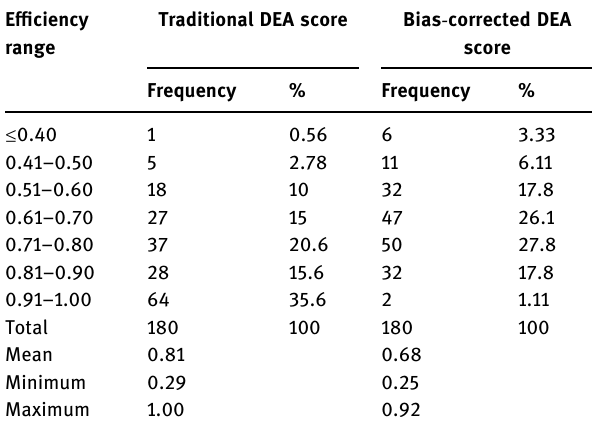
Table 2: Distribution of TE